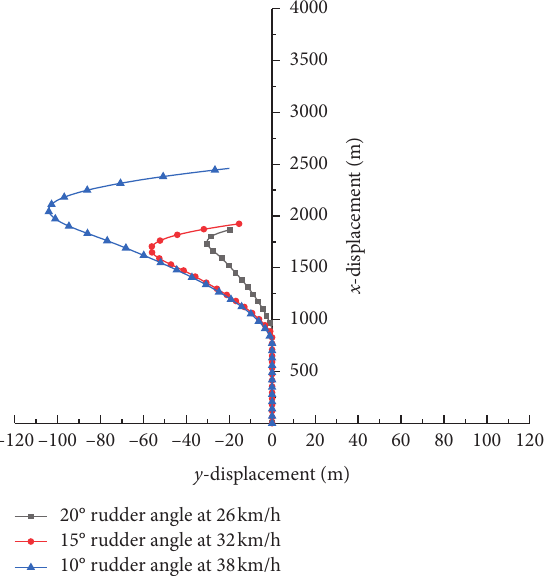
Figure 21: Trajectory of the ship at different speeds and rudder